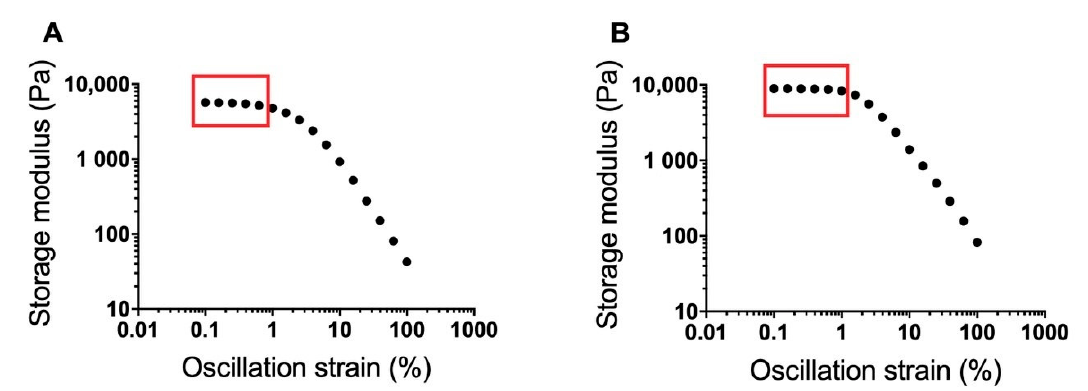
Figure 2. Strain sweeps for 17% ( A ) and 20% w/w ( B ) poloxamer gels at 37 °C. Sweeps were conducted over an oscillation strain range from 0.1 to 100%. The approximate linear viscoelastic region of each formulation is boxed. An oscillation strain of 0.2% was chosen from the two linear viscoelastic regions for use in further poloxamer rheology studies.